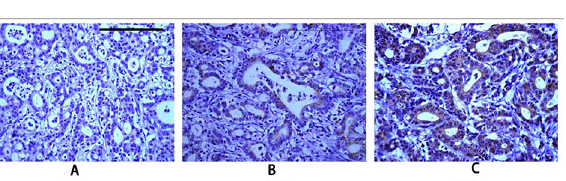
Figure 1: Expression of NLRC5 in GC specimens (A: negative; B